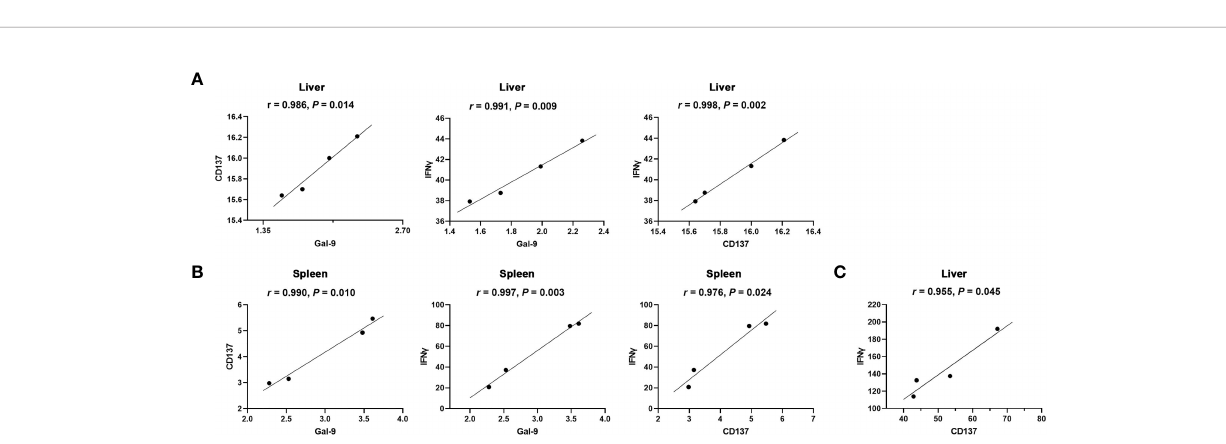
FIGURE 7 | Correlation analysis between the mRNA expression levels detected in the livers and spleens of Tg -infected mice or Tg +lact mice (n = 4). (A) Signi fi cant correlations between Gal-9 and CD137, Gal-9 and IFN g , and CD137 and IFN g in the liver, and (B) Signi fi cant correlations between Gal-9 and CD137, Gal-9 and IFN g , and CD137 and IFN g in the spleen of Tg -infected mice. (C) Signi fi cant correlation between CD137 and IFN g in the liver of Tg +lact mice. The r value generates for the theoretical line of best fi t, while the P value indicates the signi fi cance of the